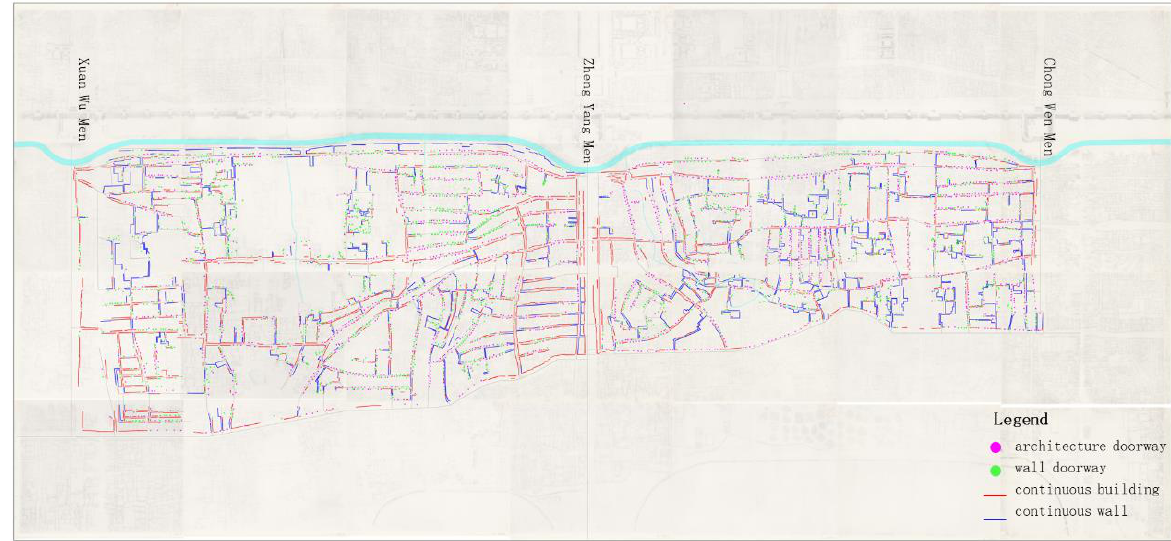
Figure 8. Abstract summary map of the four types of buildings drawing along the streets in the Qianmen